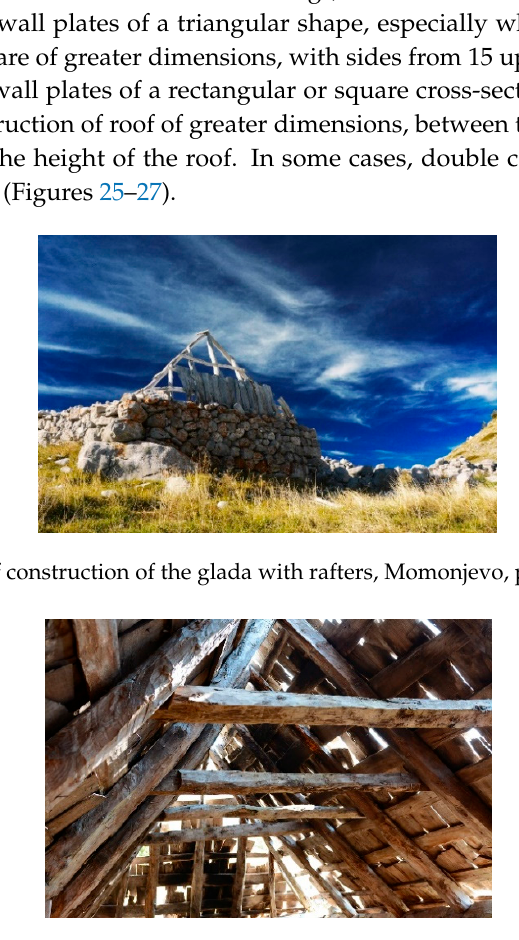
Figure 25. Roof construction with collar beams, photo: I. Lakovi ć .